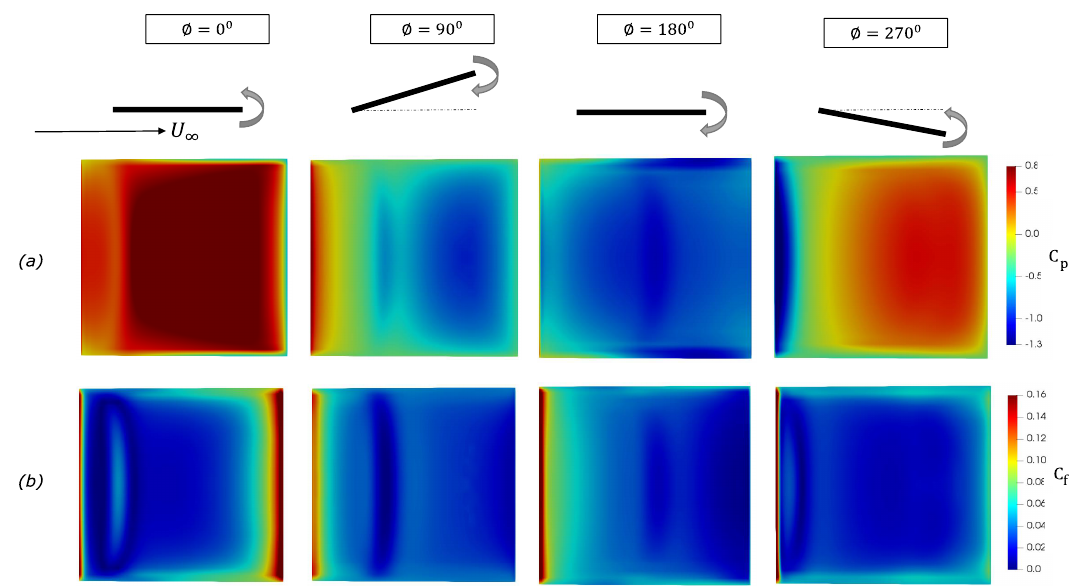
Figure 10. Contour plots for ( a ) C p and ( b ) C f variation across the top surface of pitching panel for φ = 0 ◦ ,90 ◦ ,180 ◦ and 270 ◦ , respectively. The Reynolds number is